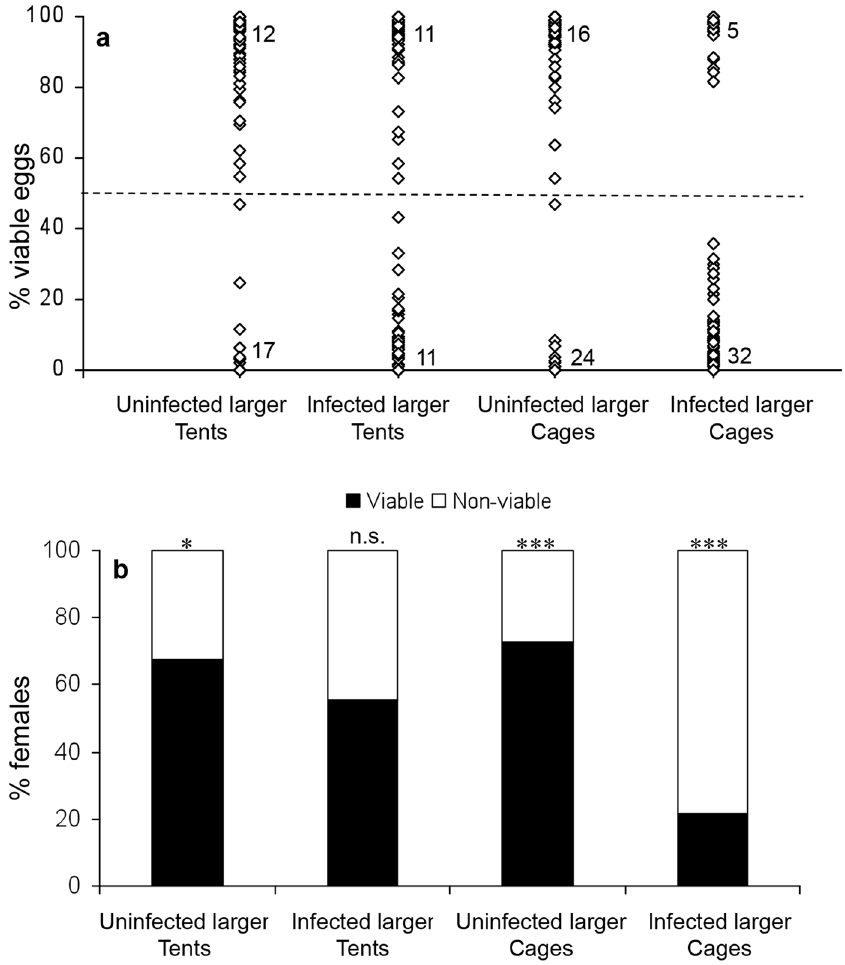
Figure 4. Experiment 3: Competitiveness of w Mel infected vs. uninfected males of different sizes. Data pooled for all females of a certain treatment. a) Percentage of viable eggs for females of tents with larger uninfected males (n=86 females), tents with larger infected males (n=93 females), semi-field cages with larger uninfected males (n= females) and semi-field cages with larger infected males (n= females). Numbers on bottom and top of figure represent the number of overlapping data points with extreme values (0% and 100% respectively). The dashed line represent the threshold for scoring females as viable ( $ 50%) or non-viable ( , 50%). b) Percentage of viable and non-viable females in each of the above treatments. Asterisks represent significance level for deviation from 1:1 using observed vs. expected chi square test with each tent/cage as a repetition (see text).